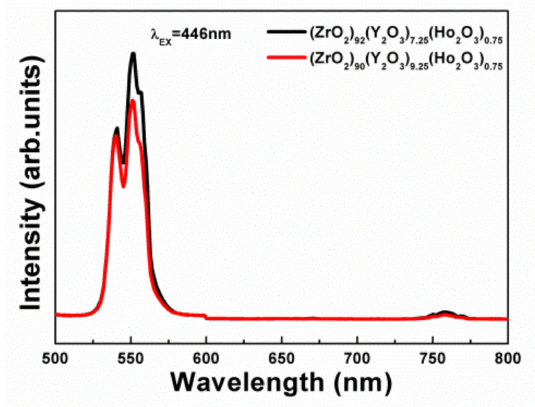
Figure 6. PL spectra for (ZrO 2 ) 92 (Y 2 O 3 ) 7.25 (Ho 2 O 3 ) 0.75 and (ZrO 2 ) 90 (Y 2 O 3 ) 9.25 (Ho 2 O 3 ) 0.75 crystals under the excitation at 446 nm.